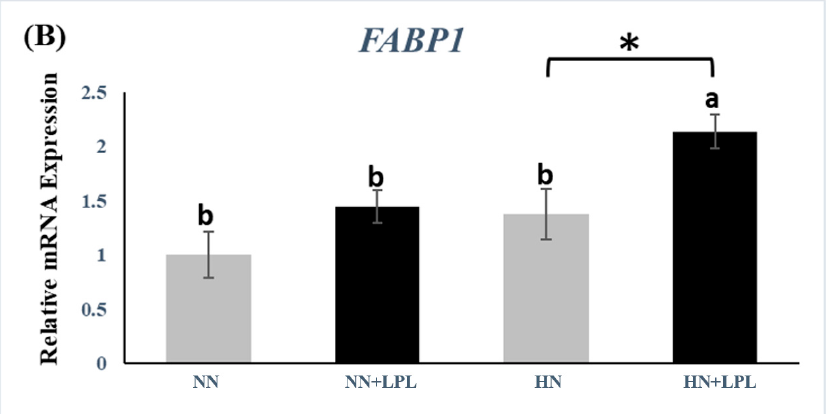
Figure 4. Quantitative gene expression of fat acids transporter in small intestine following LPL supplementation. ( A ) The gene expression of CD36. ( B ) The gene expression of FABP1. Significant differences between basal diet and diet with LPL supplementation groups are indicated by * p < 0.05. a,b Bars with no common letter differ significantly ( p < 0.05). Error bars indicate the standard error of the mean. CD 36, cluster of differentiation 36; FABP1, fatty acid-binding protein 1. Abbreviation: NN, Normal nutrition diet; NN + LPL, NN + 500 g/t of LPL; HN, NN + 0.5% CP and 50 Kcal/kg; HN + LPL, HN + 500 g/t LPL.